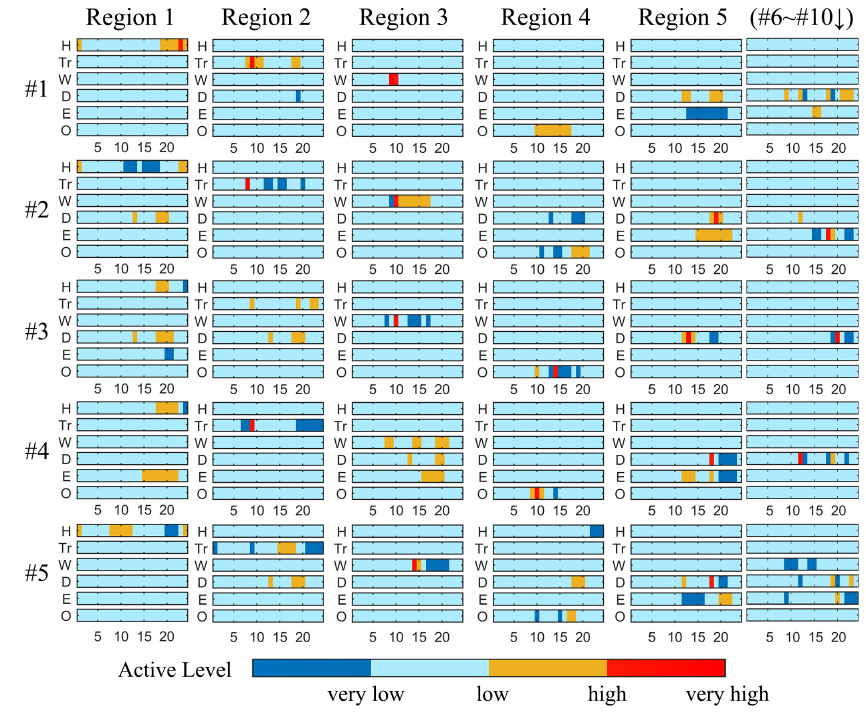
Figure 6. The significant eigenplaces of each region (each bar represents the dynamic activity level for a certain demand in a day; H, Tr, W, D, E, and O are the abbreviations for activities relating to Home, Transportation, Work, Dining, Entertainment, and Others,